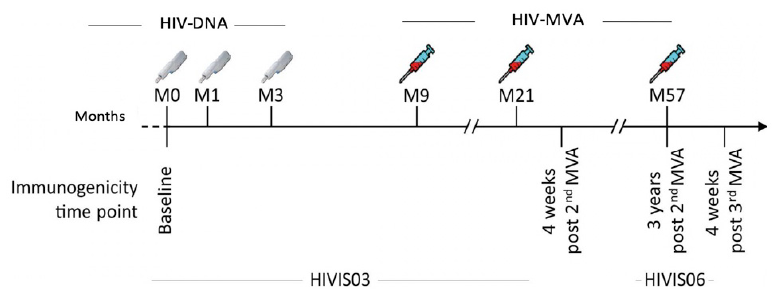
Figure 1. Vaccination schedule and immunogenicity follow up time points for HIVIS03 and HIVIS06 trials. HIV-DNA priming immunizations were given using a needle-free injection device, 1 mg intradermally or 3.8 mg intramuscularly. HIV-MVA boosting immunizations were delivered intramuscularly using needle and syringe. Each boosting vaccination contained 1 mL of 10 8 plaque-forming units (pfu) of recombinant HIV-MVA vaccine. Testing was done at baseline, four weeks after the second HIV-MVA boost, at the time of the third HIV-MVA boost and four weeks after the third HIV-MVA boost.